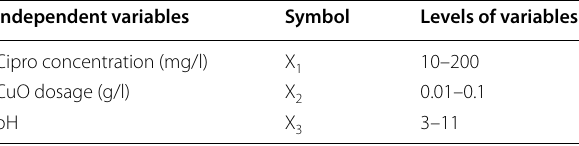
Table 1 Independent variables and their ranges Independent variables